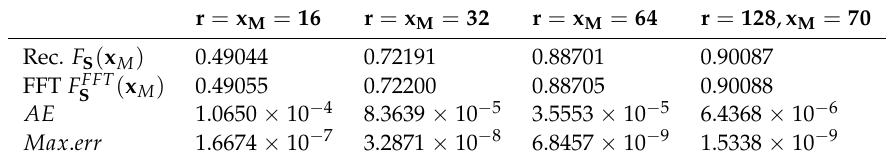
Table 5. Example 3: Comparing recursive and FFT methods for h = 1, θ = 7/ r and various r , x M